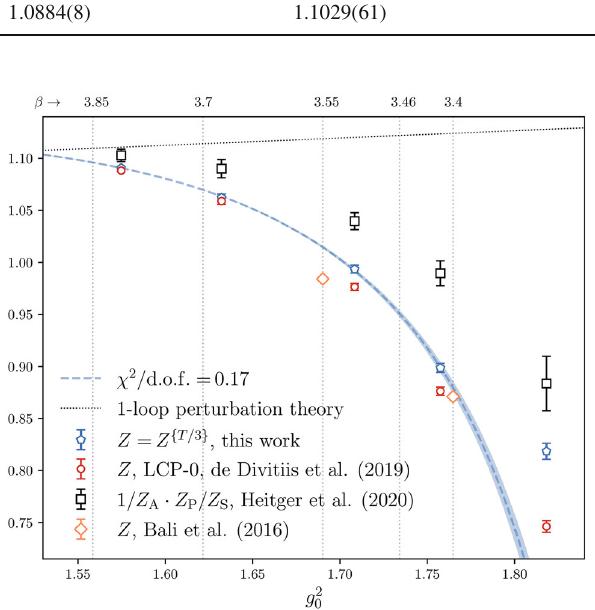
Fig. 8 Z results, obtained with different methods, as a function of the squared bare coupling g 2 . The preferred determination of this work is 0 Z = Z { T / 3 } (pentagons).Thesquaresareobtainedbycombiningresults fromRefs.[49]and[24](Heitgeretal.).Thetwo Z estimatesdetermined inRef.[32](Balietal.)aredepictedbytriangles.Thecirclescorrespond to the Z results from Ref. [14] (de Divitiis et al.). One-loop perturbation theory is illustrated by the dotted line, Ref. [14]. The dashed line shows the interpolation (C.1a) of Z { T / 3 } (excluding the coarsest latticespacing from the fit). The vertical dotted lines correspond to the bare couplings used in CLS